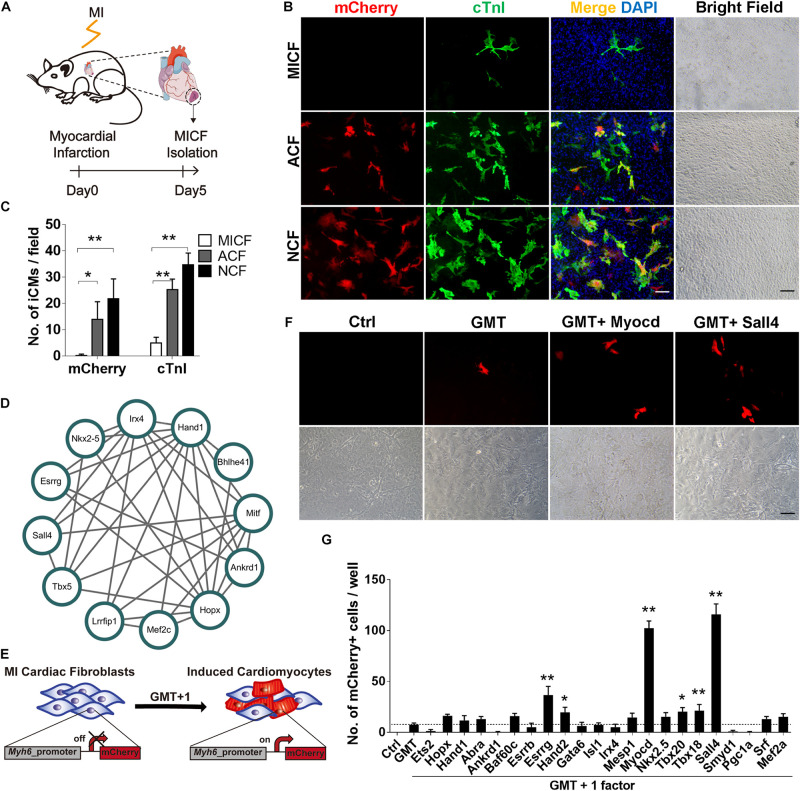
GMT is inefficient to reprogram MICFs toward a cardiac fate and screening for additional factors. (A) Flowchart of the strategy to isolate cardiac fibroblats from mice with myocardial infarction (MICFs) (B) Immunofluorescent characterization of cardiomyocyte-like cells induced by GMT from different cardiac fibroblasts 3 weeks after transduction. (C) Quantification of mCherry+ or cTnI+ cells induced by GMT (n = 4). (D) A core regulating network of transcription factors for heart development by weighted correlation network analysis of published scRNA-seq data. (E) Schematic of screening candidate transcription factors. (F) Myocd or Sall4 increased the number of Myh6-mCherry positive cells. Photographed 2 weeks after induction. (G) Quantitative data of mCherry+ cells induced by GMT plus another factor at day 14 (n = 3). All data are presented as mean ± SD. *p < 0.05; **p < 0.01 vs. relevant control. Scale bars: 100 μm.